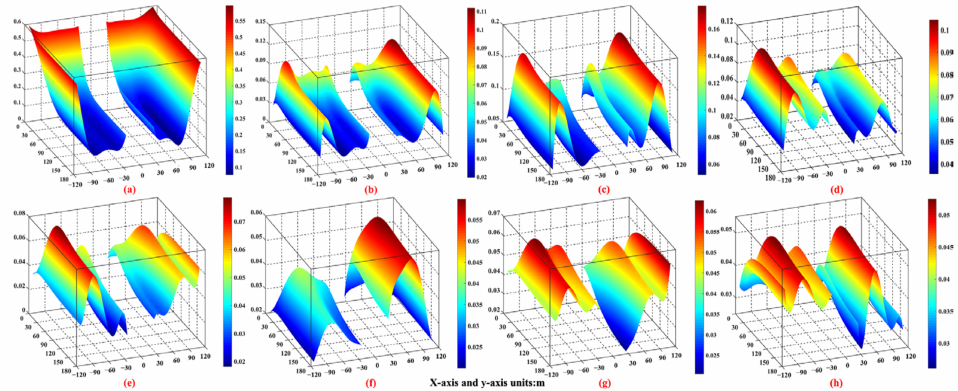
Figure 15. Porosity distribution condition of overlying strata in GFMT. ( a ) No. 16 rock stratum. ( b ) No. 15 rock stratum. ( c ) No. 14 rock stratum. ( d ) No. 13 rock stratum. ( e ) No. 12 rock stratum. ( f ) No. 11 rock stratum. ( g ) No. 10 rock stratum. ( h ) No. 9 rock